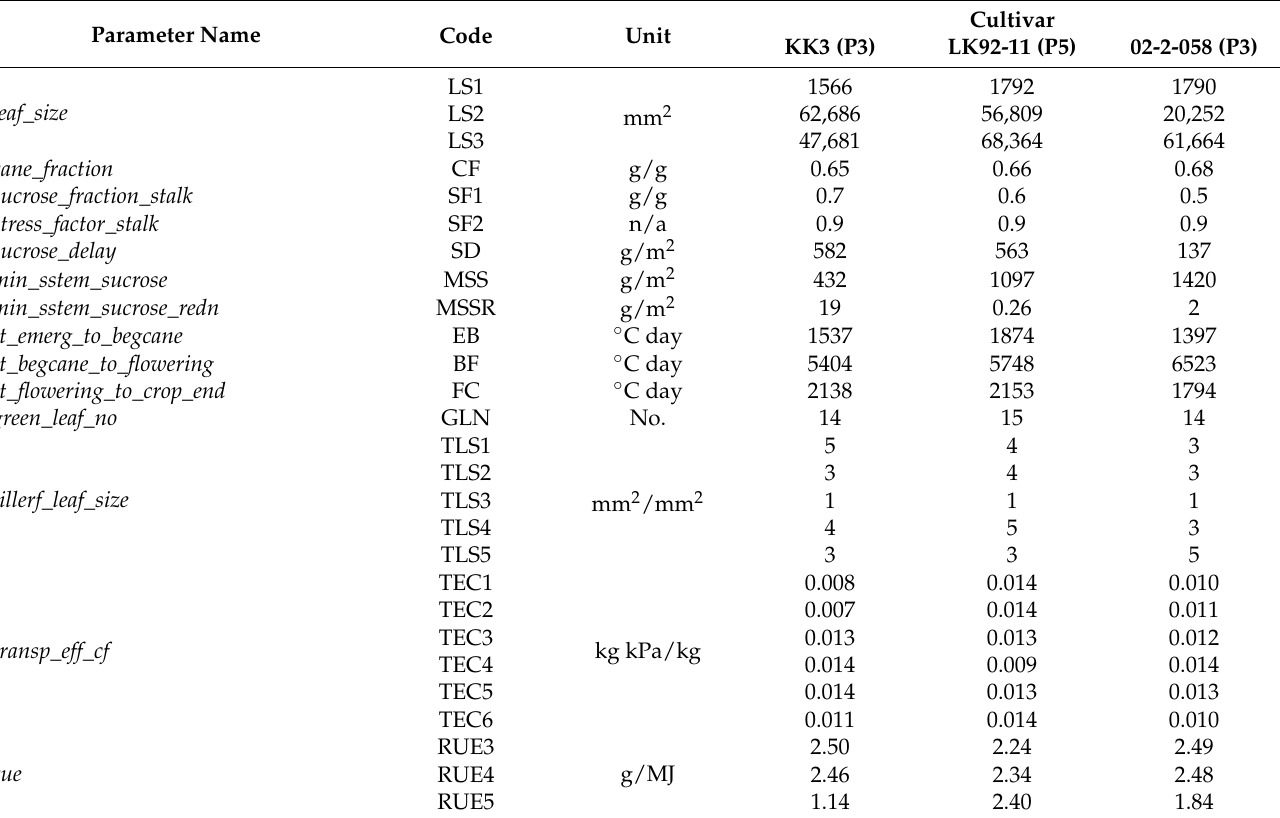
Table 4. A selection of estimated best parameters from